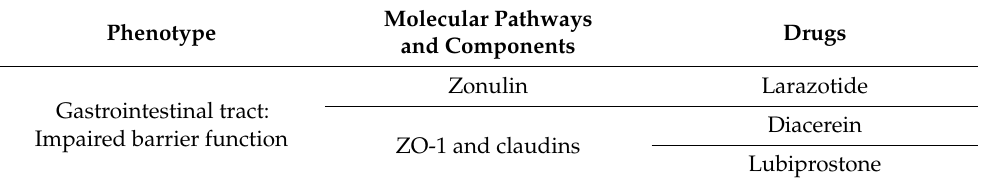
Table 7. Molecular pathways and respective drugs involved in altered gastrointestinal